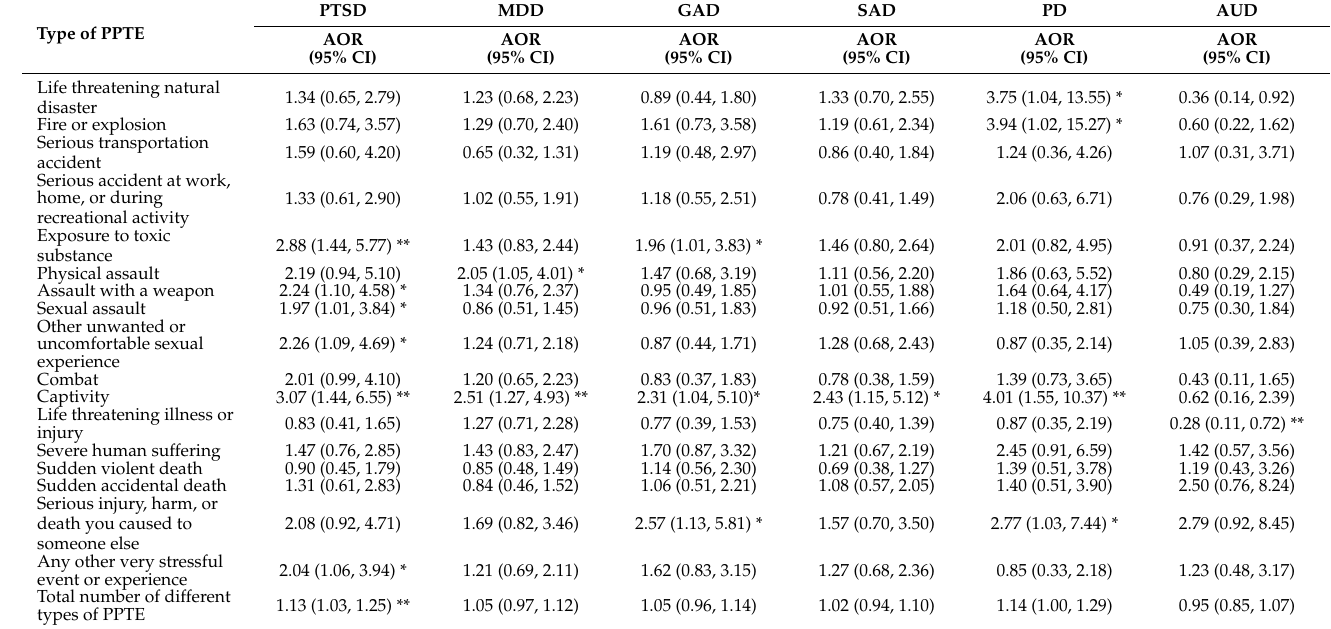
Table 5. Associations Between Potentially Psychologically Traumatic Events (PPTEs) Exposure and Screening Positive for Mental Disorder (Adjusted for Sociodemographic and Job